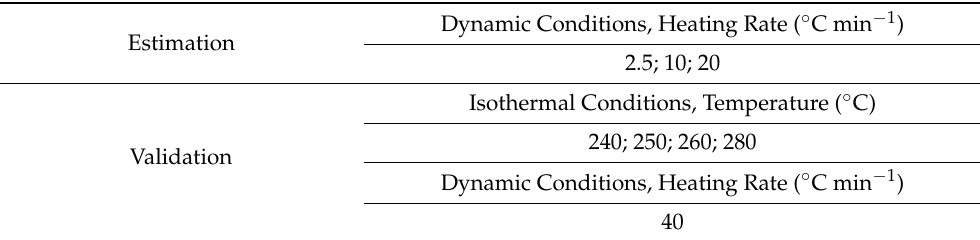
Table 1. Conditions of DSC experiments performed to estimate and validate the kinetics of the thermal decomposition of PA.